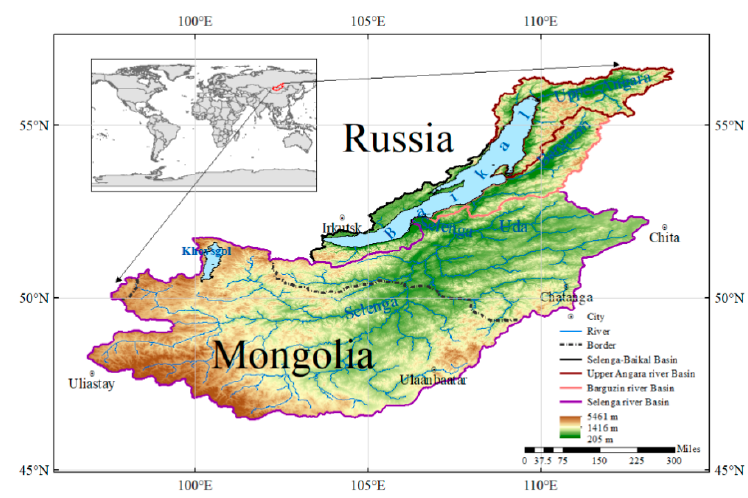
Figure 1. Topographical map of the Selenga-Baikal Basin.